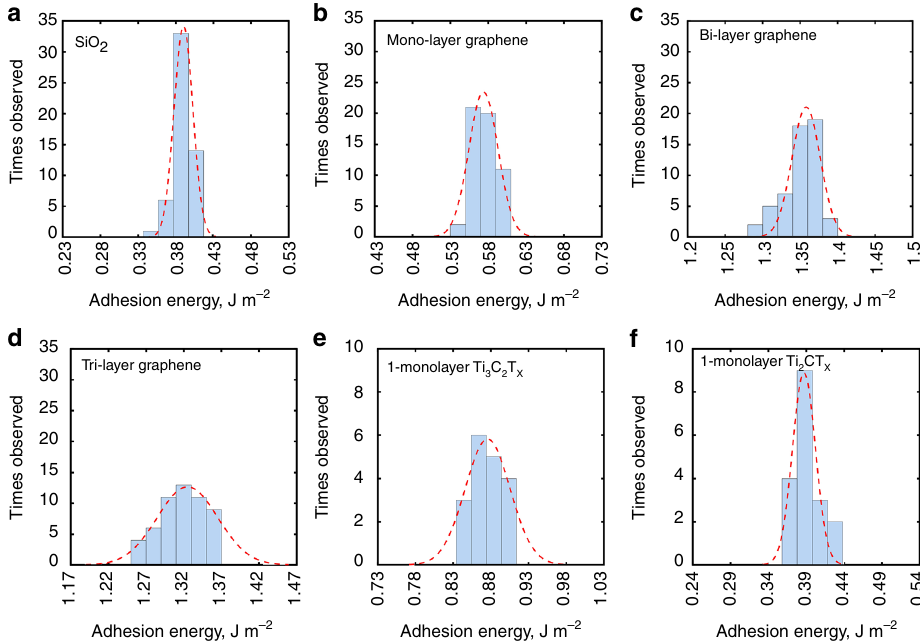
Fig. 4 Histograms of calculated adhesion energies for: a SiO 2 /SiO 2 , b mono-layer graphene/SiO 2 , c bi-layer graphene/SiO 2 , d tri-layer graphene/SiO 2 , e 1- monolayer Ti 3 C 2 T x /SiO 2 , and f 1-monolayer Ti 2 CT x /SiO 2 . (The total count is 54 for SiO 2 and graphene and 18 for MXene)